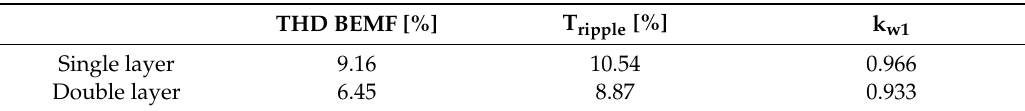
Table 1. Comparison between the single and double layer for a 1.4 kW machine with Q = 12, p = 10.